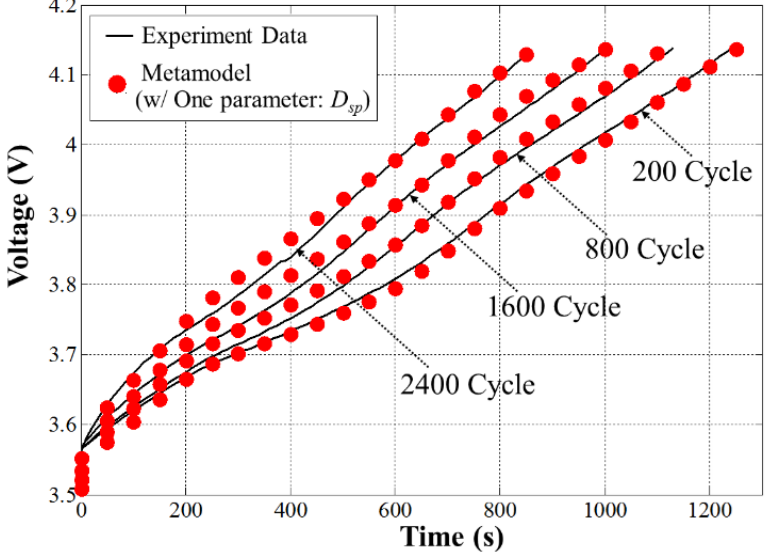
Figure 7. Comparision of the voltage obtained from the metamodel with experimental